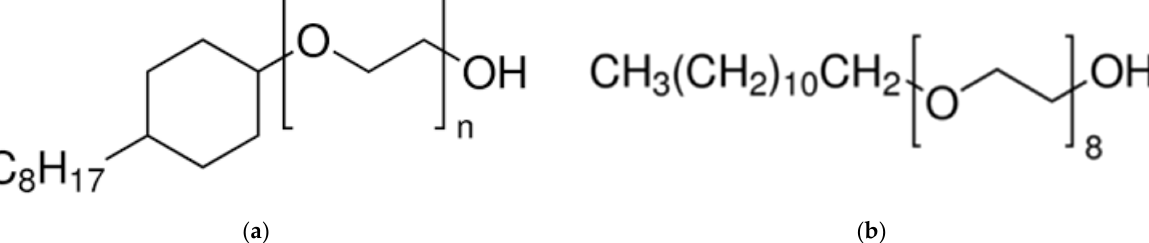
Figure 2. ( a ) Reduced tritonX-100 and ( b ) octaethylene glycol monododecyl ether (C 12 E 8 ). Courtesy Sigma-Aldrich limited.